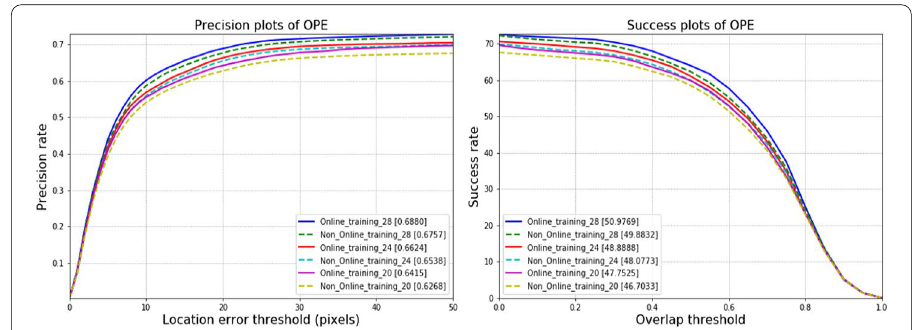
Fig.13 Success and precision plots of different channels on OTB2013 datasets with Online or Non-online training